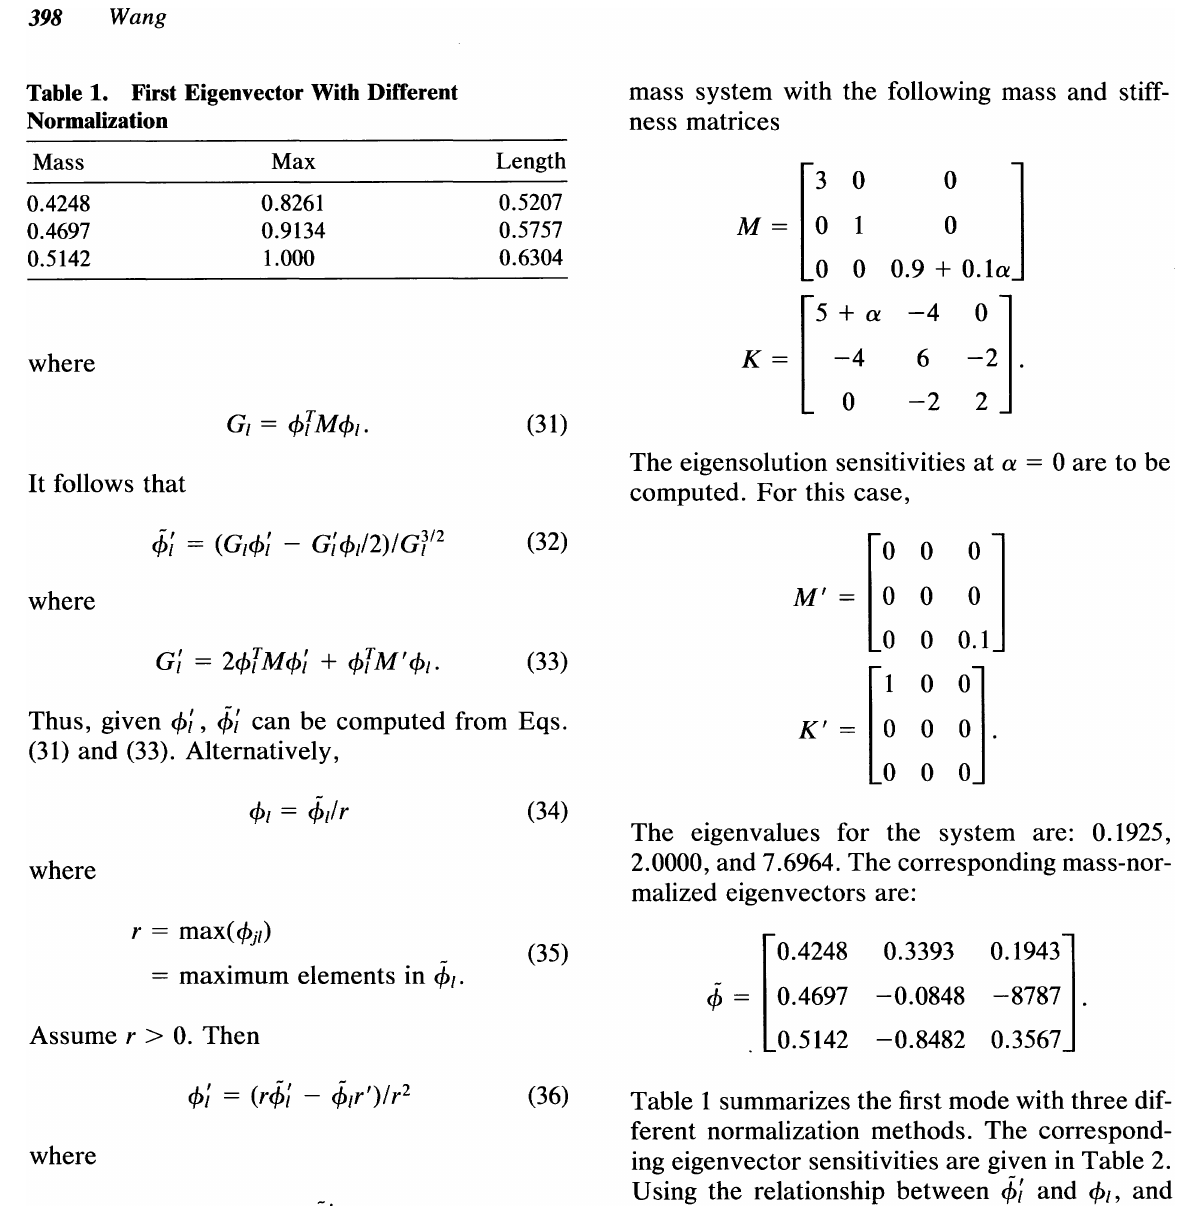
Table 1. First Eigenvector With Different Normalization